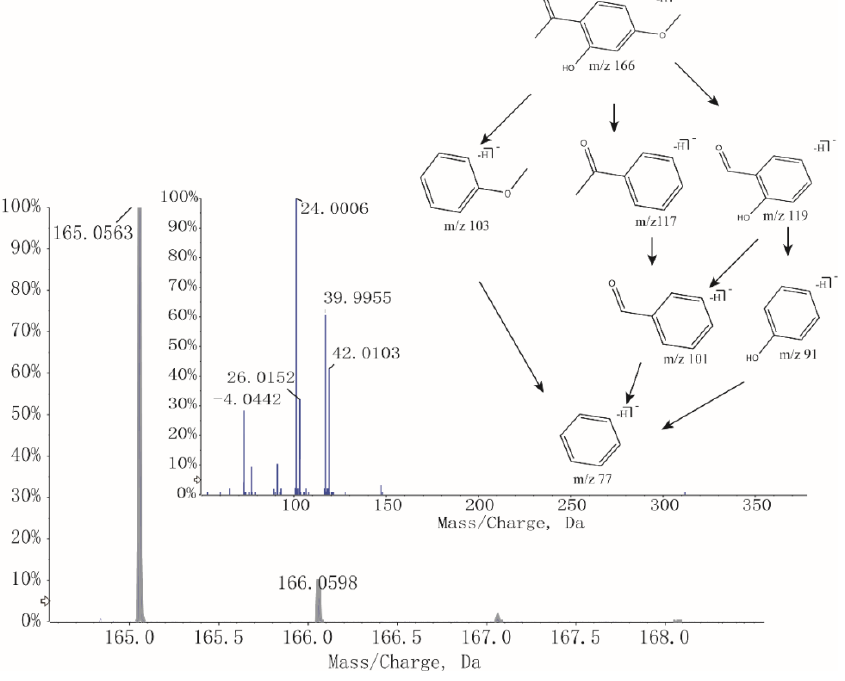
Figure 4. MS and tandem mass spectroscopy (MS/MS) spectra and fragmentation of Paeonol.